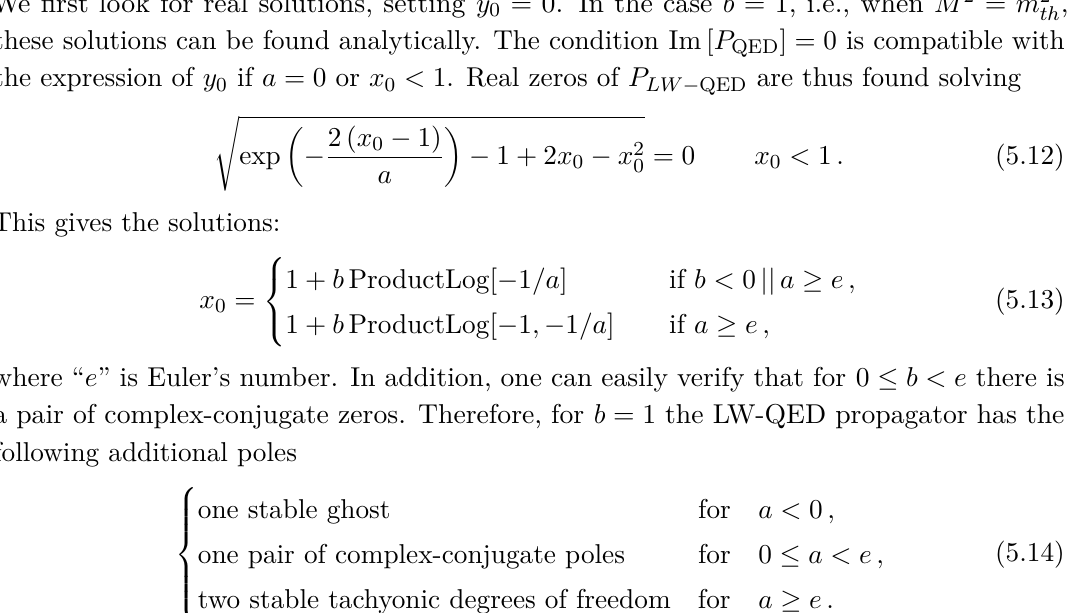
Figure 13 . Pole structure of the Lee-Wick P -function in eq. (5.3) as a function of a , and for b = 1 . The figure shows the real (magenta dots) and imaginary (blue dots) part of the zeros of P Beyond the massless pole, the propagator has a stable ghost for a < 0 , while for a > e there are two tachyonic ghosts. For 0 < a < e , the massive real pole splits into a pair of complex-conjugate poles. Since a 1 , in Lee-Wick QED there is a pair of complex-conjugate LW − QED (cid:28)